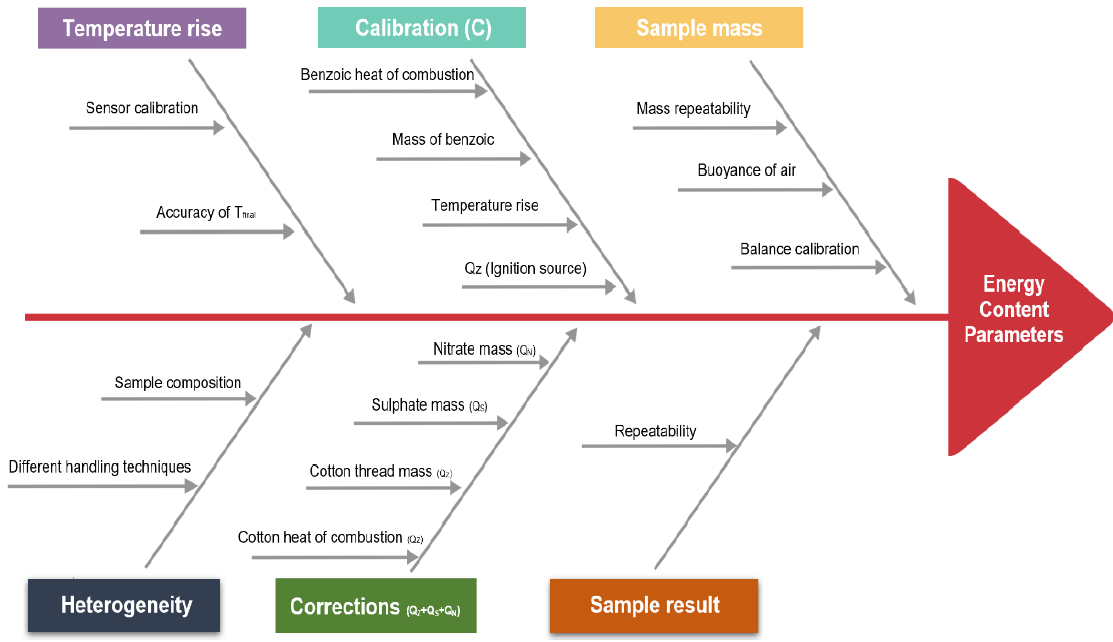
Figure 7. Uncertainty sources associated with the determination of the calorific value.